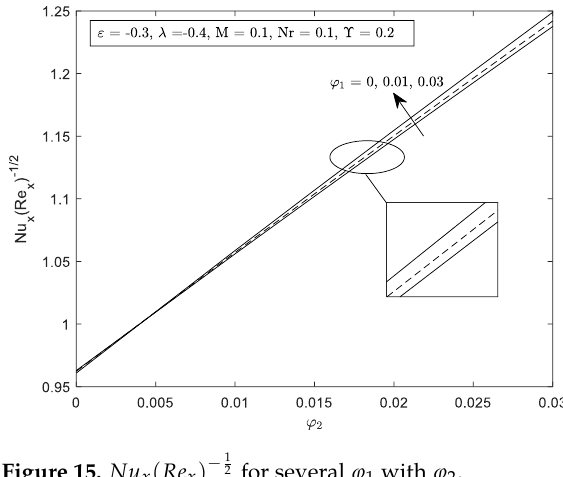
Figure 14. C f ( Re x ) Figure 14. 𝐶 𝒇 (𝑅𝑒 𝒙 ) Figure 14. 𝐶 𝒇 (𝑅𝑒 𝒙 )